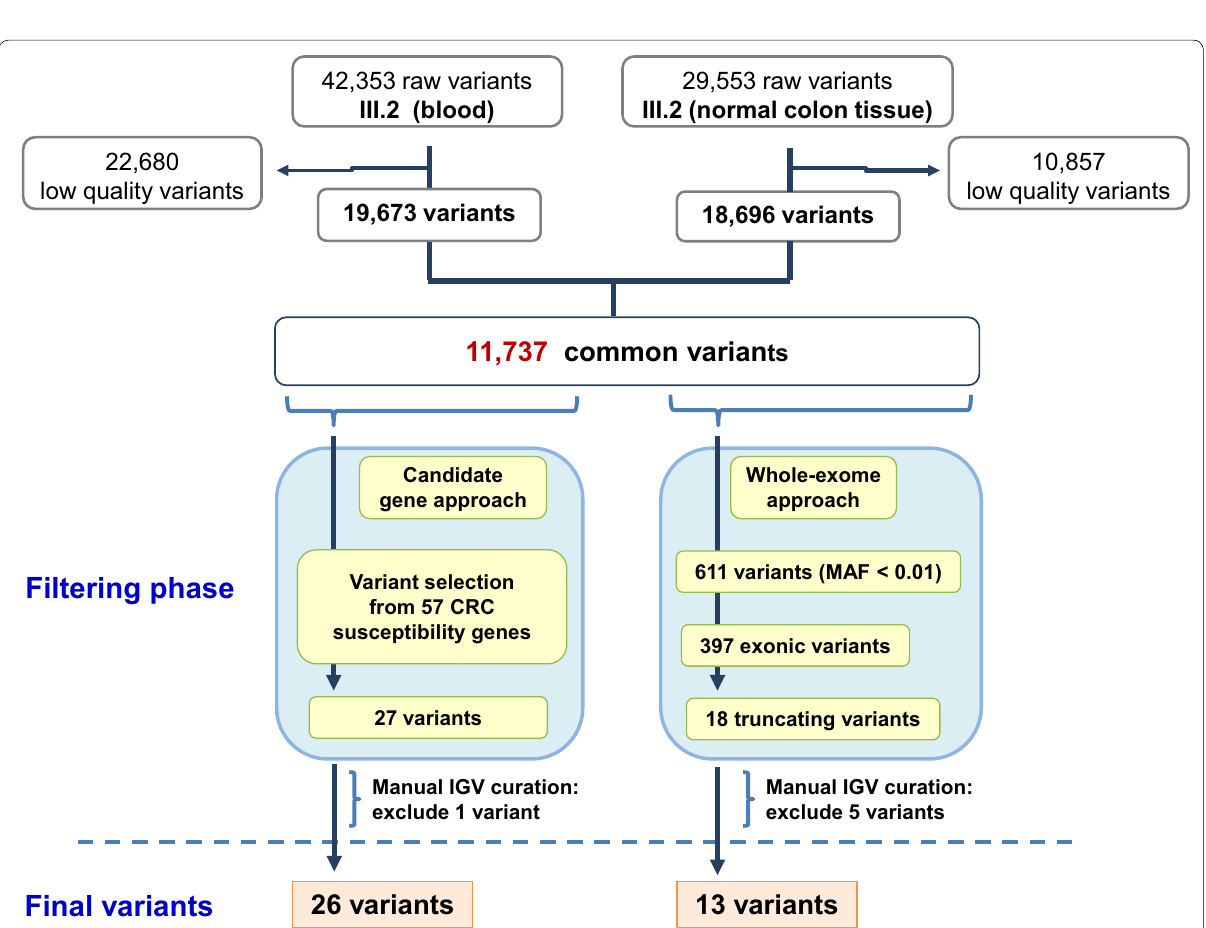
Fig. 2 Analysis of the workflow applied to prioritize variants found in the whole-exome sequencing (WES) data from the proband. Two differ- ent sources of the proband’s DNA (blood and normal colon tissues) were analyzed with WES. A quality filter was first applied to minimize false positive variants, permitting us to obtain 19,673 and 18,696 variants in DNA in the blood and normal colon tissues from the proband, respectively. Since massively parallel sequencing can generate artifacts, a total of 11,737 variants shared between the two sources of DNA were used to apply a twofold strategy to identify variants associated with CRC. The first approach (“candidate gene approach”) selected 26 variants from the 57 CRC susceptibility genes; the second approach (“whole-exome approach”) selected 13 truncating variants with a minor allele frequency (MAF) <0.01. IGV the Integrative Genomic Viewer